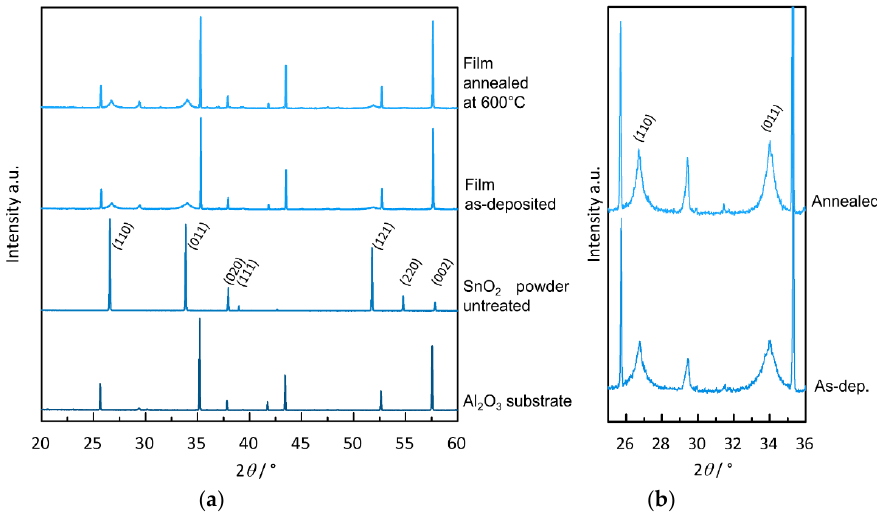
Figure 5. ( a ) XRD spectra of Al 2 O 3 substrate, untreated SnO 2 powder, as-deposited film as well as film annealed at 600 °C with equalized maximum intensities and ( b ) detailed view of the film patterns; (Miller indices are given for main SnO 2 -reflexes).